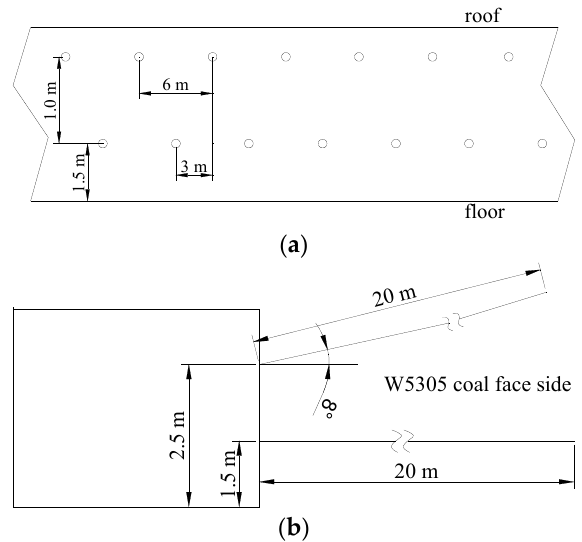
Figure 18. Grouting drilling arrangement in 53031 roadway: ( a ) Drilling layout in the triangular zone; and, ( b ) side view of the grouting holes.